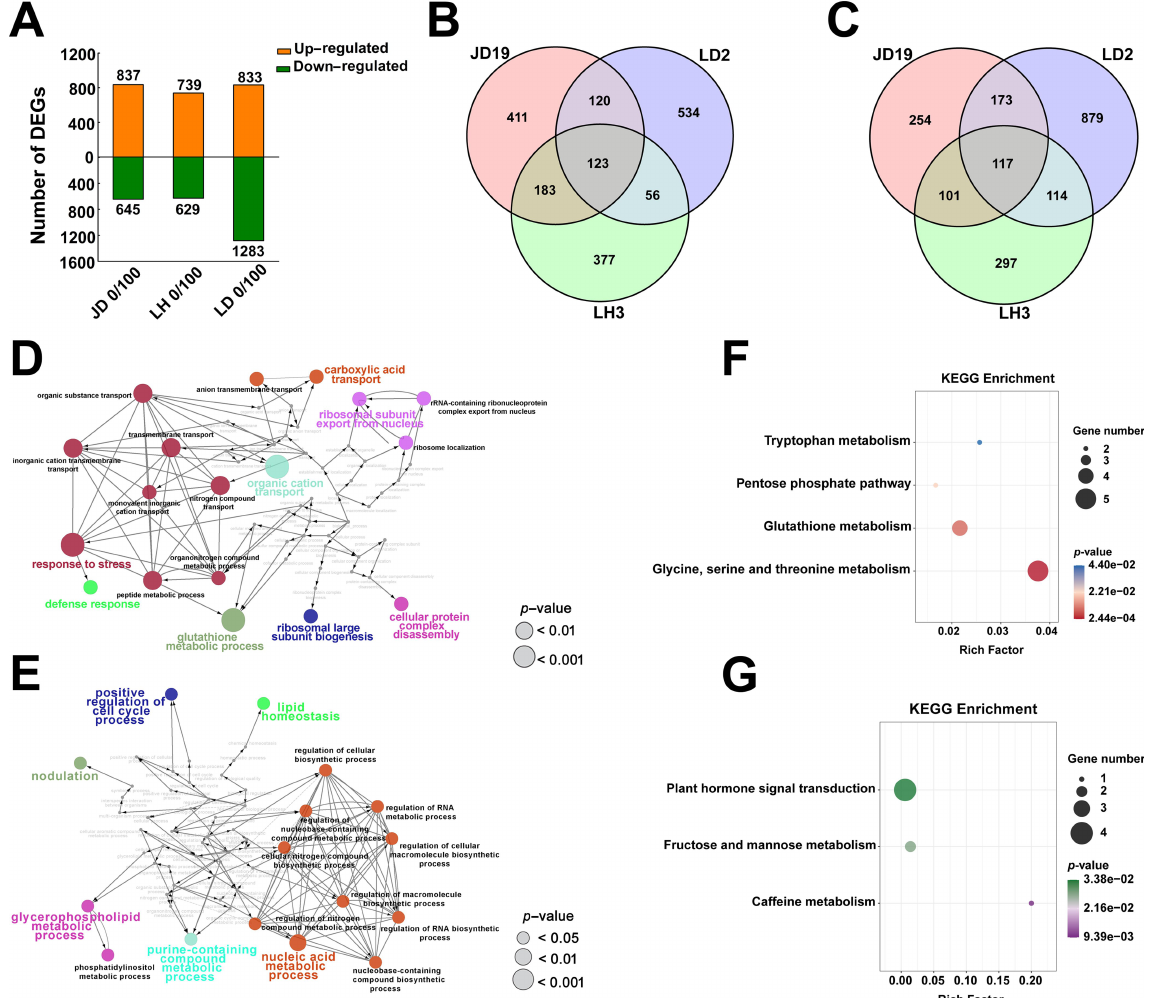
Figure 3. Transcriptome analysis of three soybean cultivars under 100 mM NaCl treatment. Statistics of DEGs ( A ), Venn diagram showing the overlapping and non-overlapping up-regulated DEGs ( B ), and down-regulated DEGs ( C ) among three soybean cultivars under 100 mM NaCl treatment. GO term of common up-regulated DEGs ( D ), and common down-regulated DEGs ( E ), KEGG pathway of commonly up-regulated DEGs ( F ), and common down-regulated DEGs ( G ) between JD19 and LH3 under 100 mM NaCl treatment. ClueGO analysis generated functionally grouped networks with GO terms as nodes linked based on their kappa score level (≥0.4). Colors reflect the label of the most significant term per group. The node size represents the term enrichment significance.